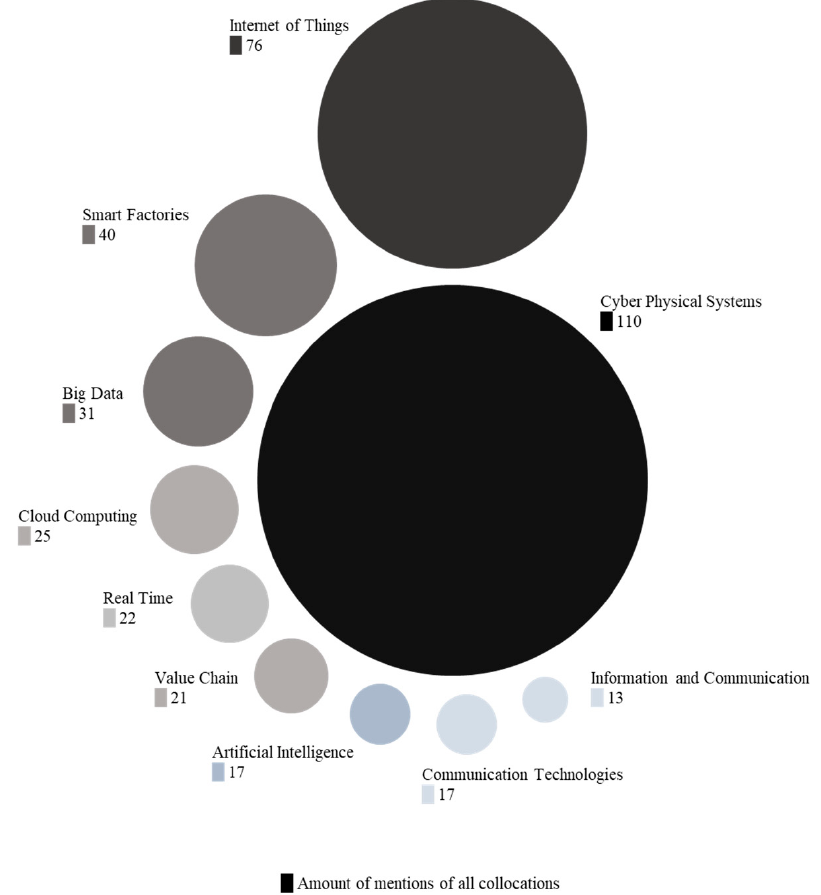
Figure 6. Overview of the most frequent collocations to define Industry 4.0 in the reviewed litera-